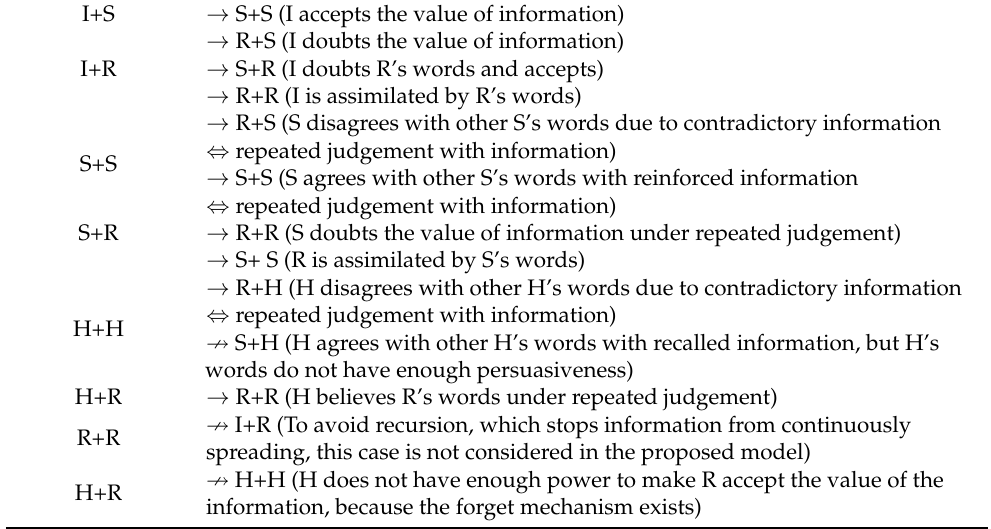
Table 1 (I = ignorant, S = spreader, H = hibernator, R = stifler). Table 1. Definition of the interactions during information spreading for state